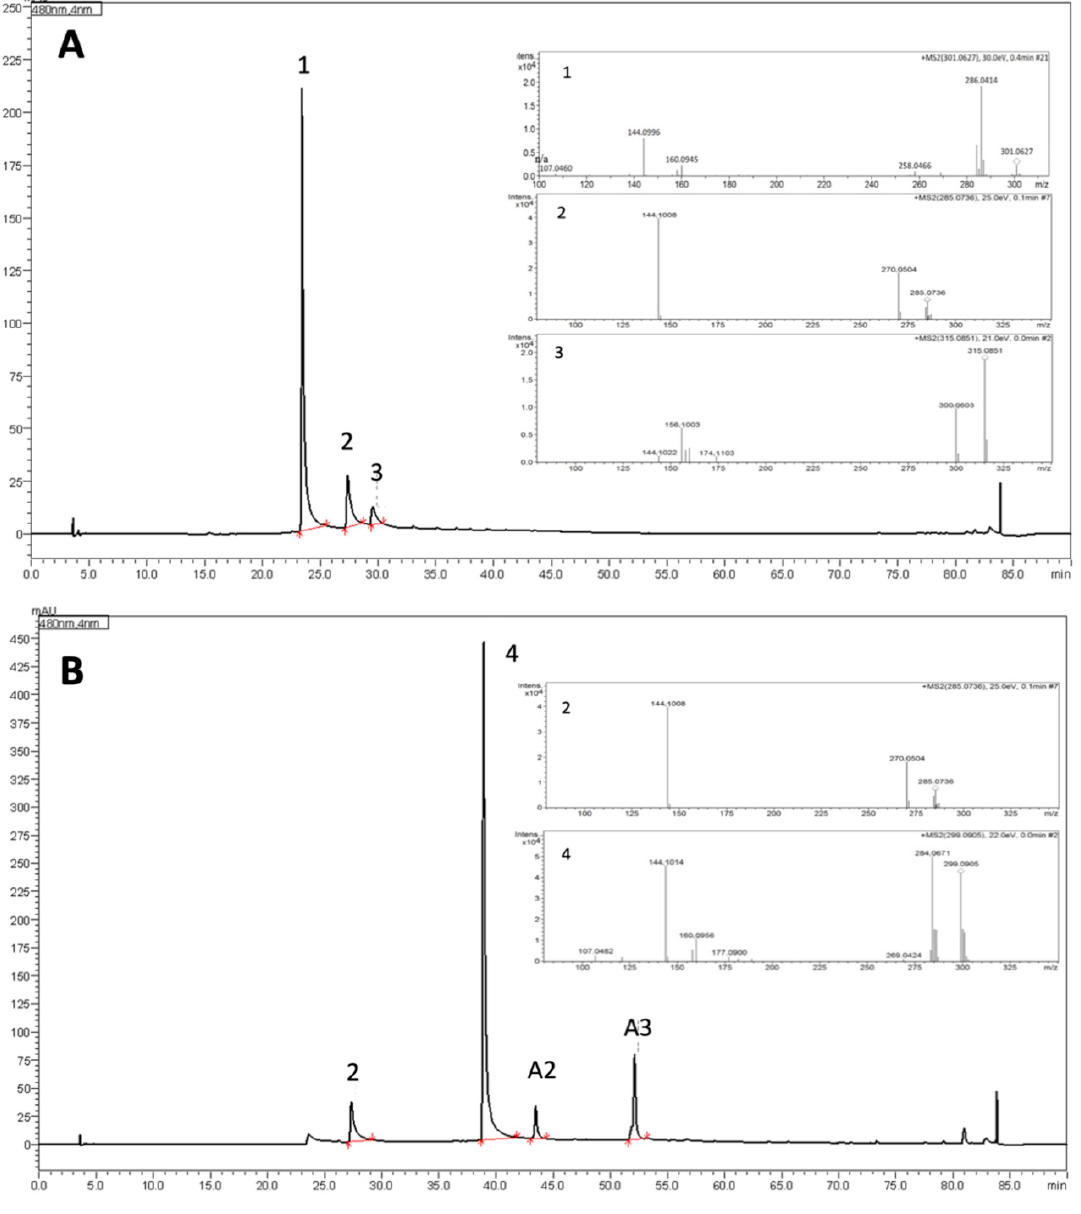
Figure 2. Chromatograms of morphotypes I (W) ( A ) and IV (S) ( B ) showing the elution order of anthocyanidins 1–4 and their respective mass spectra. A . Compound 1 (Rt = 23.5 min; M + [H] + at m / z 301.0627; compound 2 (Rt = 27.4 min; M + [H] + at m / z 285.0736 and compound 3 (Rt = 29.5 min; M + [H] + at m / z 315.0851). B . compound 4 (Rt = 39.0 min; M + [H] + at m / z 299.0905). Compounds A2 and A3 (Rt = 43.5 min and 52.1 min) showed M + [H] + at m / z 317.0756 and m / z 287.0614, respectively. Another three anthocyanidins indicated as A1 (Rt = 25.4 min), A2 (Rt = 43.5 min) and A3 (Rt =